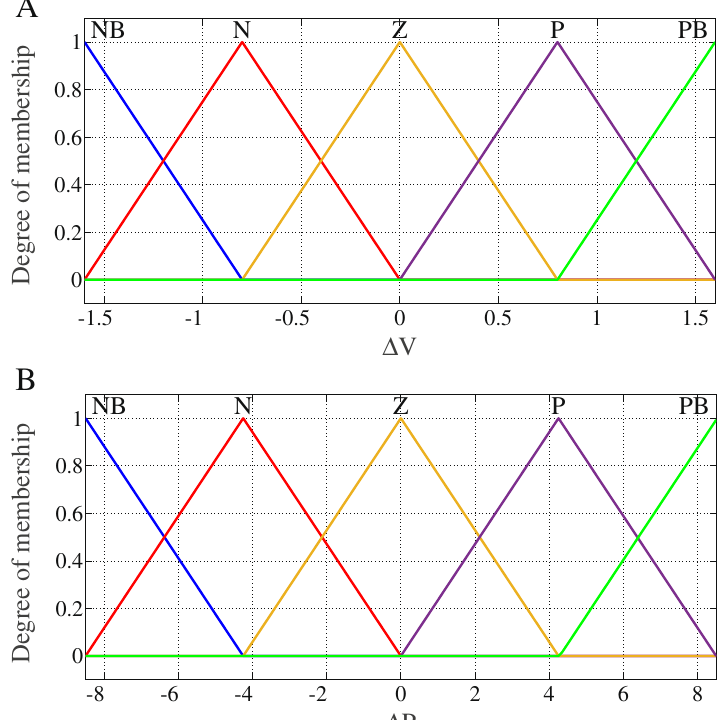
Fig. 7 Output membership variable of the fuzzy MPPT (cid:31) D